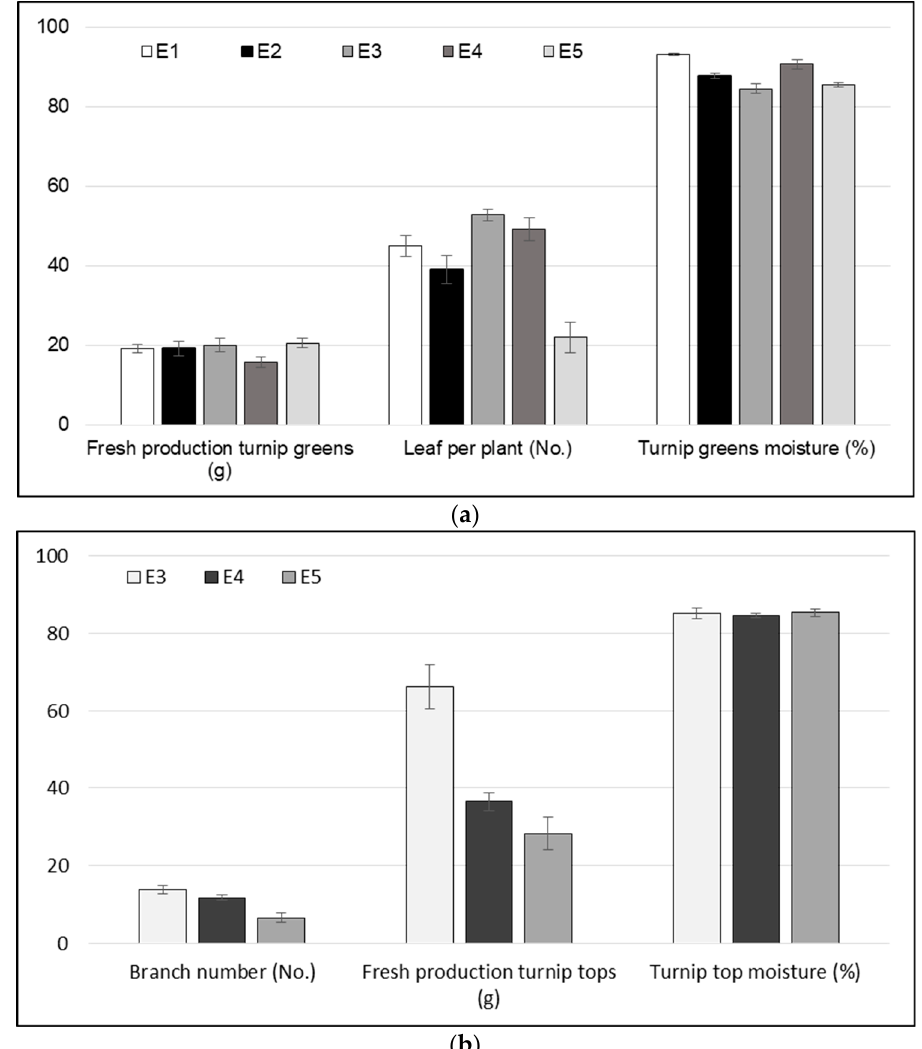
Figure 1. ( a ) Means for traits related to turnip greens fresh production: fresh production turnip greens (g), leaf per plant (No.), and turnip greens moisture (%) at the five environments where varieties were grown (E1 = Pontevedra 2016; E2 = Catania 2016; E3 = Pontevedra 2017; E4 = Oroso 2017; E5 = Catania 2017). ( b ) Means for traits related to turnip tops fresh production: branch number (No.), fresh production turnip tops (g) and turnip top moisture (%) at the three environments where varieties were grown (E3 = Pontevedra 2017; E4 = Oroso 2017; E5 = Catania